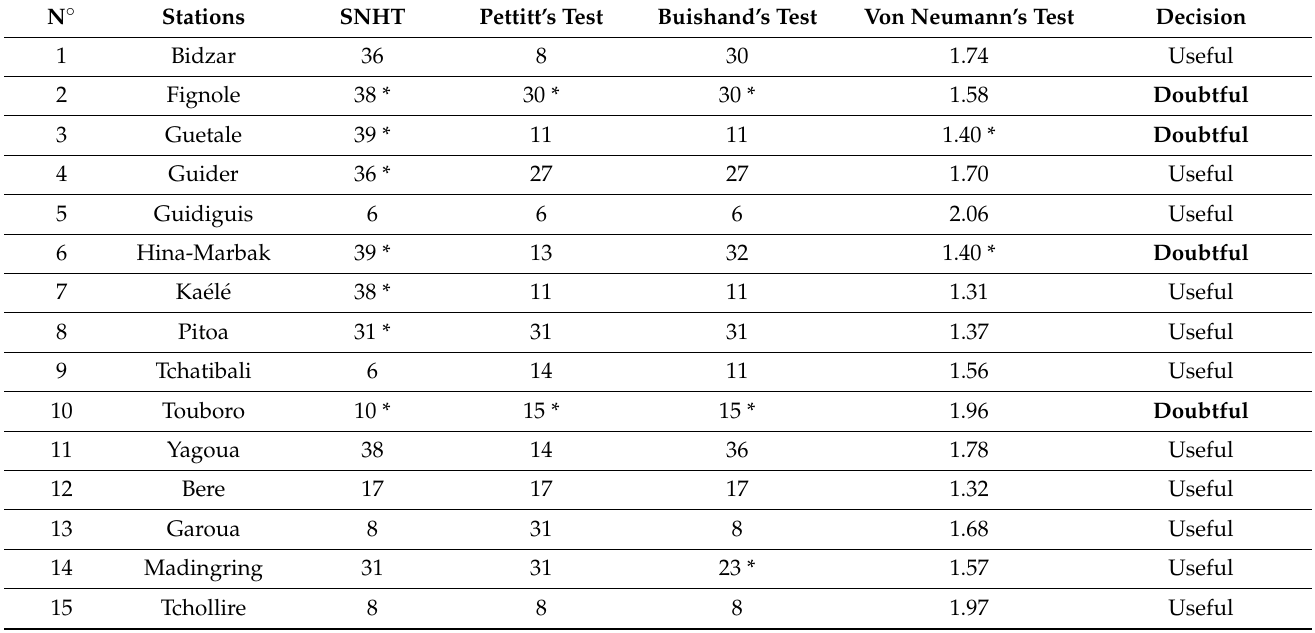
Table 3. Statistical test of homogeneity applied to the annual rainfall count series of the main climate stations in the Sudano-Sahelian region of Cameroon. (*) indicates that the test rejects the null hypothesis at the 1% level and the annual data series is not